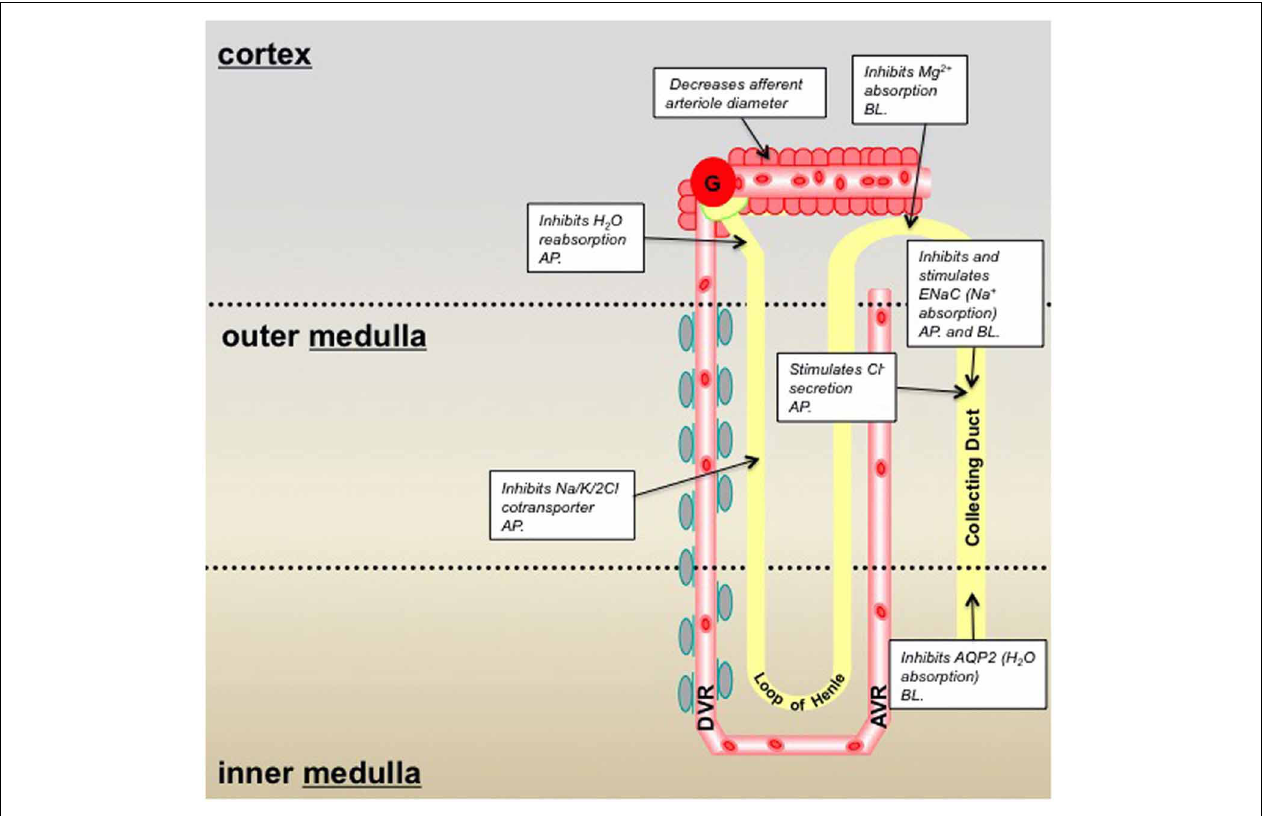
FIGURE 1 | Summary of P2X receptor-mediated effects in the kidney and epithelial cell lines derived from specific nephron segments; pre-2010/11. Information taken from: Wildman and King,